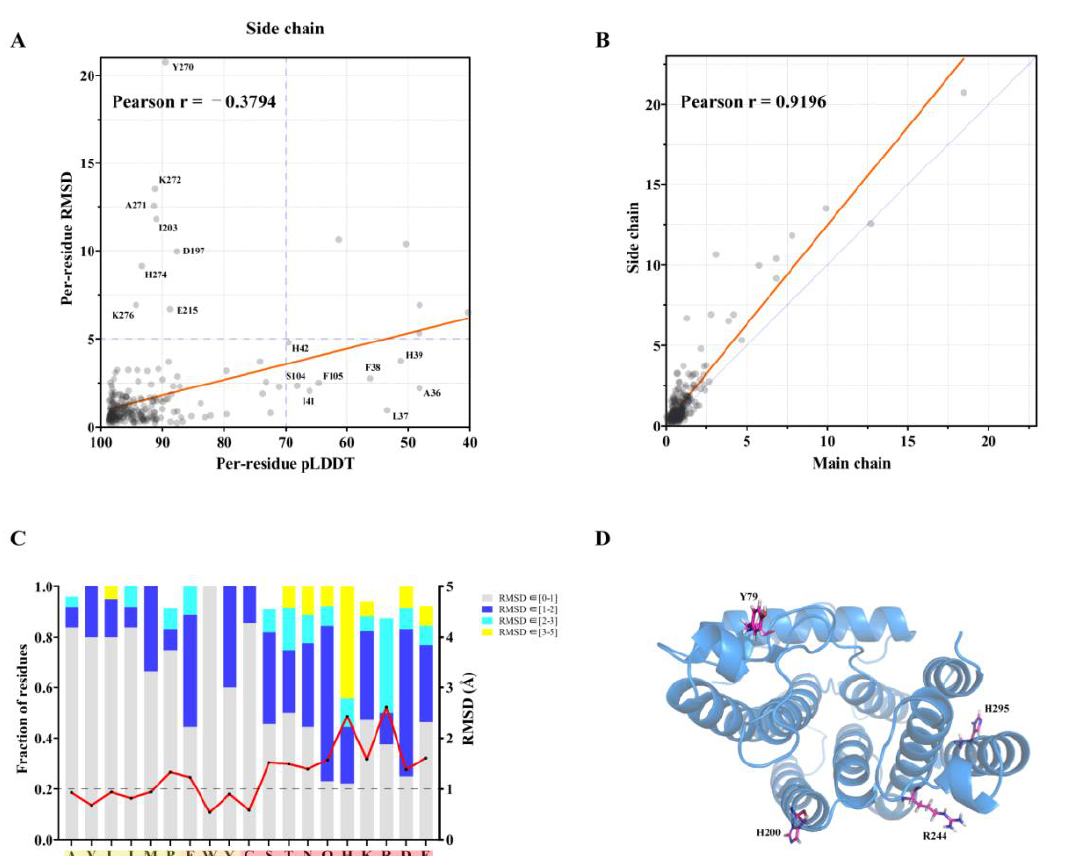
Figure 3. Accuracy analysis of the AF2 predicted B318L protein side-chains. Note that 243 residues extracted from a total of 261 experimentally solved residues are used for side-chain analysis, excluding 18 residues of glycine which comprises only one hydrogen atom in its side-chain. ( A ) A comparison of side-chain RMSD values with per-residue pLDDT scores. Each dot in the scatter plot represents one residue common in both the predicted and experimental B318L structures. Some outliers are labeled for clarity. The red line is the line of best fit. Pearson’s r = − 0.3794 and the least-squares linear fit is y = ( − 0.0879 ± 0.0138 ) × x + ( 9.712 ± 1.283 ) . The dotted blue lines indicate a pLDDT score of 70 and RMSD of 5 Å. ( B ) Correlation between side-chain RMSD values and main-chain RMSD values. The red line shows the best fit and the blue line shows x = y for comparison. Pearson’s r = 0.9196 and the least-squares linear fit is y = ( 1.23 ± 0.034 ) × x + ( 0.169 ± 0.071 ) . ( C ) Mean RMSD values for each amino acid type (red line) and the fraction of the residues belonging to the same amino acid type divided into different regions of RMSD values (bar graph). All residues are divided into three groups and colored according to their names, classified into polar (red), nonpolar (yellow), and aromatic amino acids (orange). Note that only residues with side-chain RMSD values less than 5 Å are used for statistical analysis to avoid sufficiently large model bias. ( D ) Examples of representative amino acid residues with apparent disagreement of side-chain positions are plotted on the protein molecule as sticks.